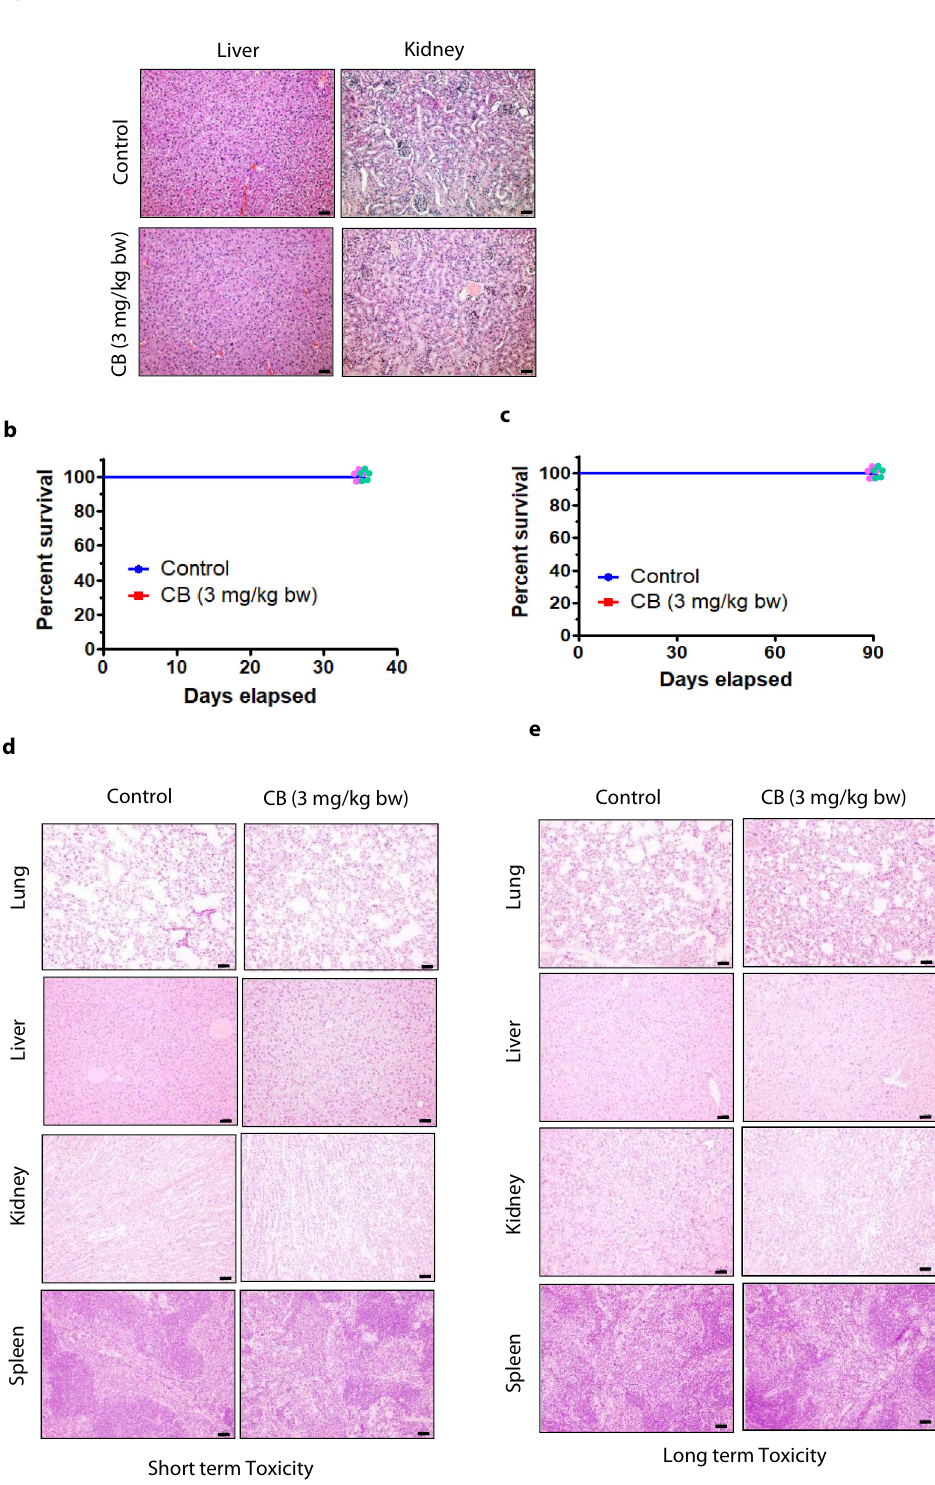
Fig. 3 CB is a safe and viable anticancer compound. a Representative H&E-stained sections of livers and kidneys from CB-intraipid (nano-CB)-treated mice show no signs of liver and renal toxicity in an orthotopic xenograft model. Scale bar, (10X, 10 µ m). b , c Survival of 4 – 5 weeks old BALB/cJ mice treated with vehicle (Control) or CB-intralipid for short or long durations. Mice received vehicle or nano-CB (3 mg/kg b.w., intravenously; n = 5/group) once per week for 4 weeks. b One set of mice was sacri fi ced after 24 h of fi nal CB administration. c For long-term toxicity studies, mice were followed for an additional 2 months. d , e Representative H&E-stained sections of lungs, livers, kidneys, and spleens from BALB/cJ mice treated with vehicle 24 or nano-CB for short- ( d ) and long-term ( e ). Scale bar, (10X, 10 µ